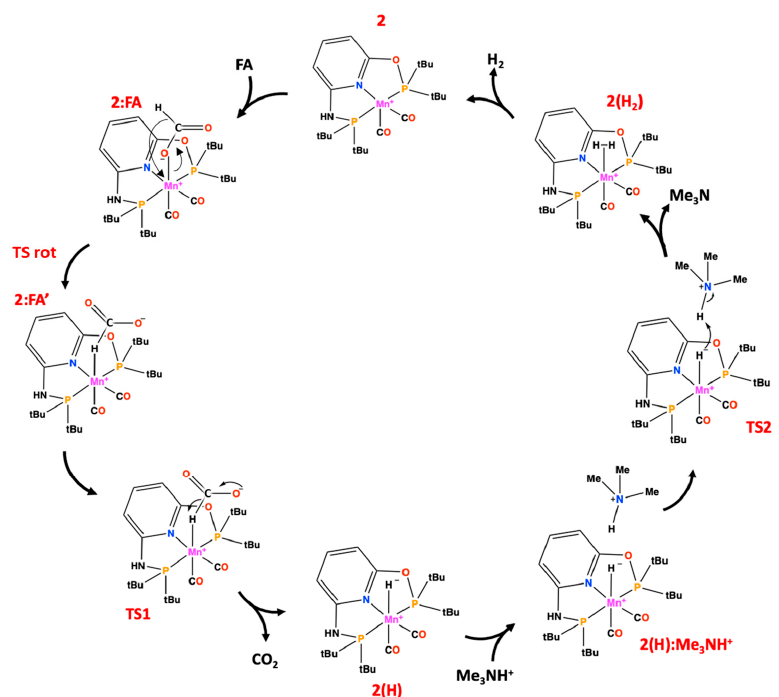
Figure 1. Free energy profile of the FA to CO 2 conversion catalyzed by complex 2 at the B3LYP- D3/6-311+G(2d,2p)/SDD/Chlorobenzene level of theory. Energy barriers are depicted in red.